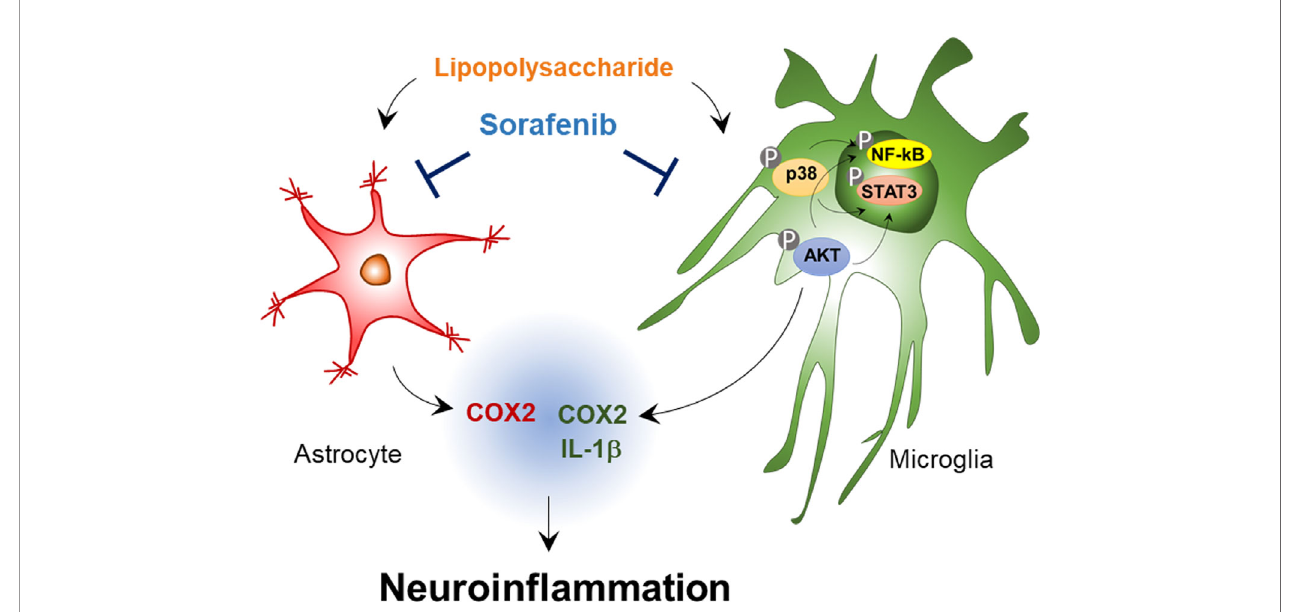
FIGURE 9 | Sorafenib affects LPS-stimulated neuroin fl ammatory responses in vitro and in vivo . In BV2 microglial cells and wild-type mice, sorafenib reduces the effects of LPS on the mRNA levels of the proin fl ammatory cytokines IL-1 b and COX-2 in microglia and COX-2 in astrocytes by modulating AKT/P38-associated NF- kB/STAT3 signaling pathways. Accordingly, sorafenib may have therapeutic potential for neuroin fl ammation-related